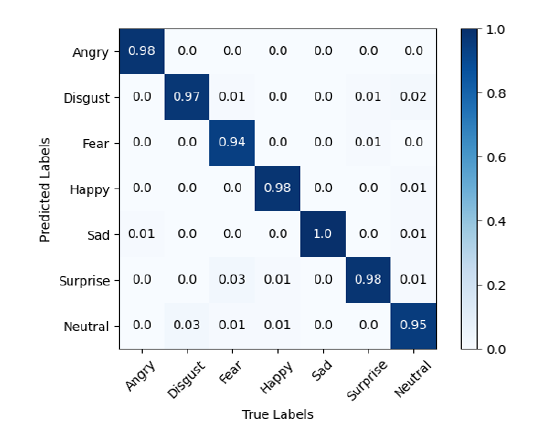
Figure 7. The confusion matrix of FERDERnet_X when trained on the on-road driver facial expression